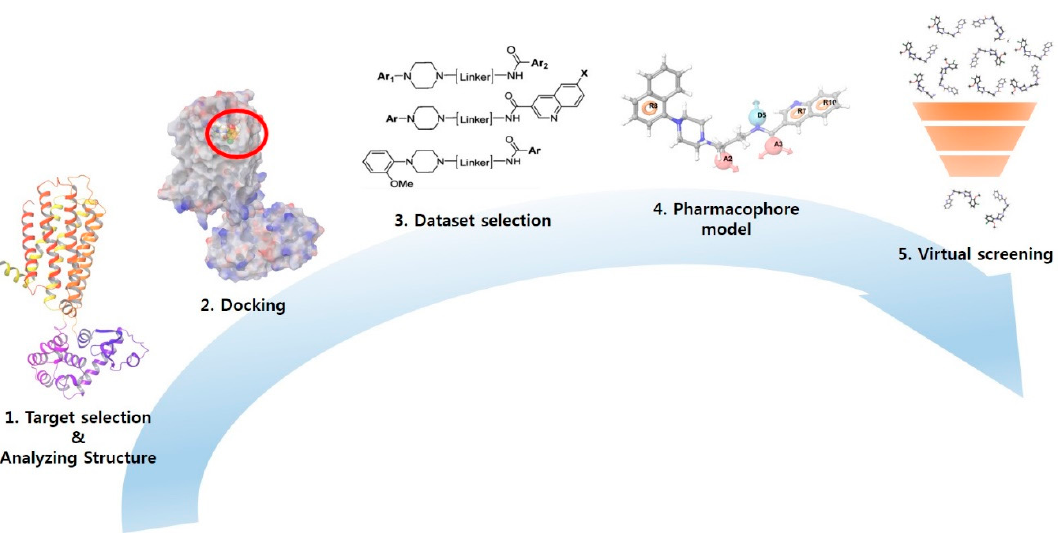
Figure 2. Workflows of this study.